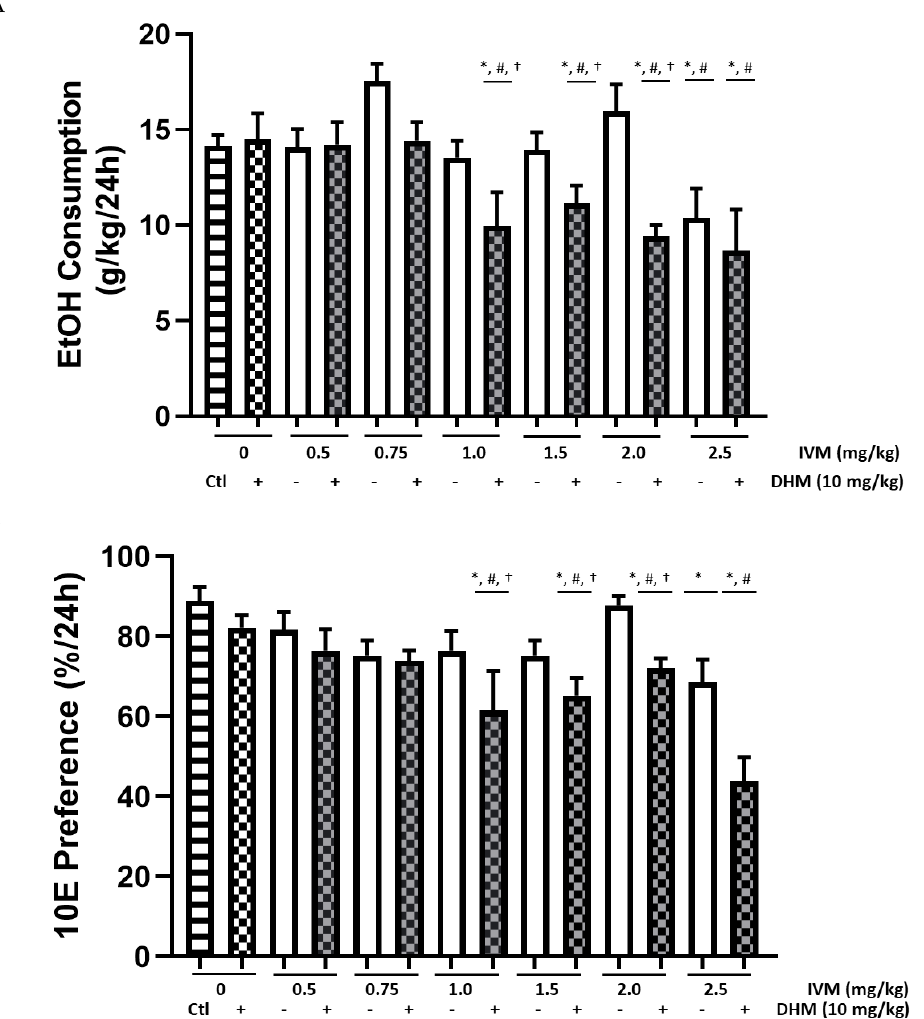
Figure 3. DHM (10 mg/kg) combined with IVM significantly reduces the dosing for EtOH consumption and 10E preference in female C57BL/6J mice over a period of 24 h. ( A ) IVM (1.0–2.5 mg/kg) combined with DHM (10 mg/kg) significantly reduced EtOH intake relative to saline treatment (Ctl), with 1.0–2.0 mg/kg IVM and DHM showing significant effects compared to IVM doses alone. ( B ) IVM (1.0–2.0 mg/kg) combined with DHM significantly reduces 10E preference in comparison to IVM controls. IVM (1.0–2.0 mg/kg) and DHM (10 mg/kg) significantly reduced 10E preference relative to saline values. Ctl = saline; DHM = dihydromyricetin; IVM = ivermectin. * p < 0.05 vs. Ctl values, † p < 0.05 vs. corresponding IVM dose control, and # p < 0.05 vs. DHM control; n = 48/group for DHM and saline groups; n = 8/group for IVM and IVM + DHM groups. All values are shown as averages ± SEM. 2-way ANOVA followed by Bonferroni’s multiple comparisons.